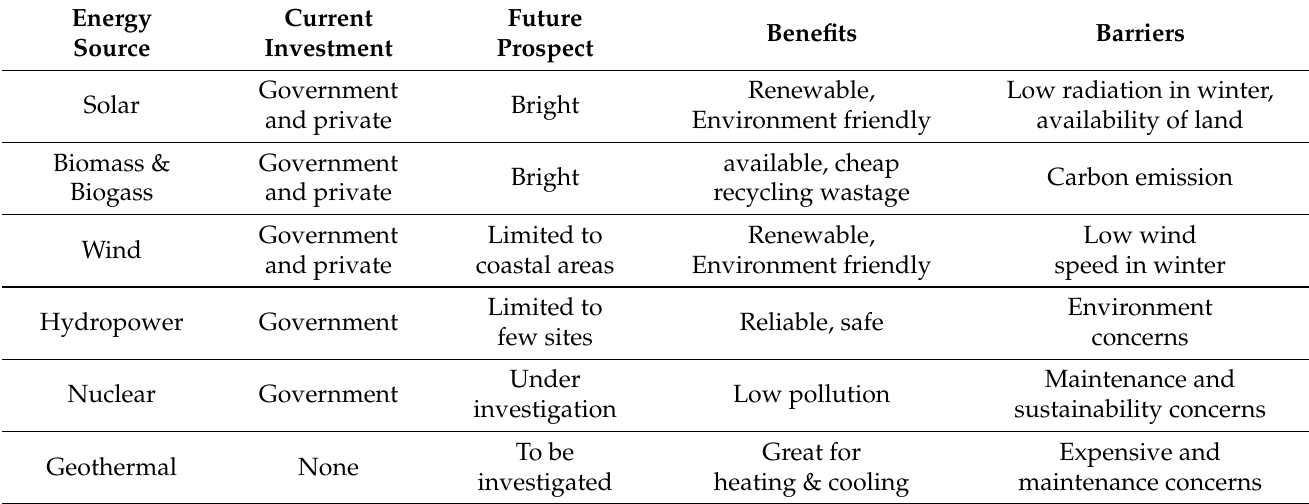
Table 9. Prospects of RE in